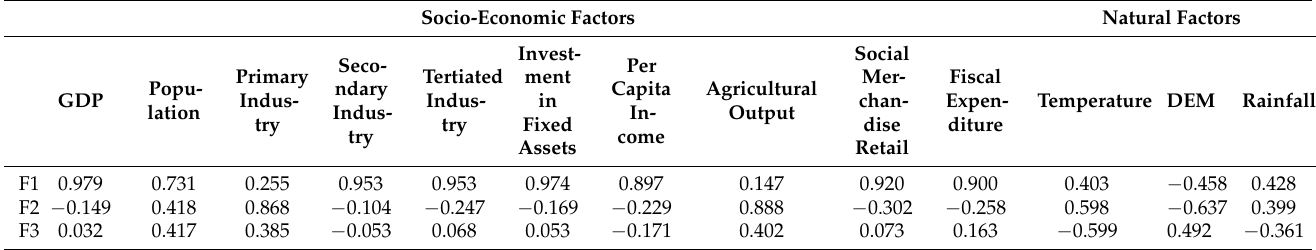
Table 7. Principal component factor loading